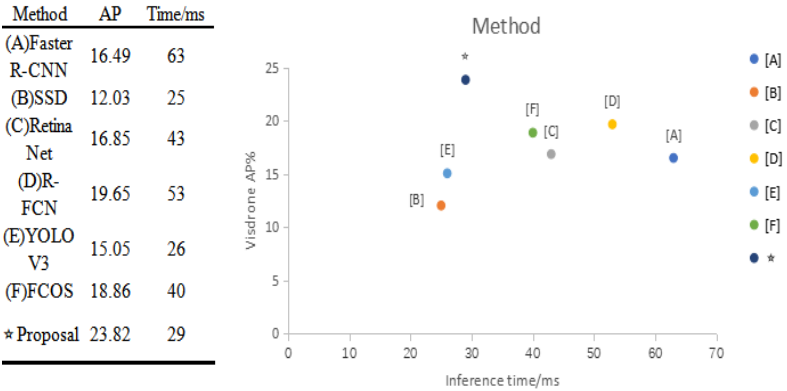
( d ) YOLOV3 Figure 7. Comparison chart of the detection effect between the algorithm in this paper and some classic algorithms. ( a ) Proposal; ( b ) RetinaNet; ( c ) Faster R-CNN; ( d ) YOLOV3. This paper extracts target sample instances during the day and night, respectively, and compares the detection results of the four algorithms. It can be seen that RetinaNet, Faster R-CNN, and YOLOV3 have different degrees of missing detection for small targets and targets with similar distances, while the algorithm feature learning in this paper is relatively sufficient. Compared with the other three algorithms, there were no missed or false detections. In summary, the detection accuracy of the proposed algorithm for all kinds of targets is higher than the other three, especially for small targets. This is because AFBS can better combine the superior information of high-level features and low-level features in the feature map through the adaptive fusion of multi-layer features and has stronger identification and localization ability for small targets and multi-scale targets. In